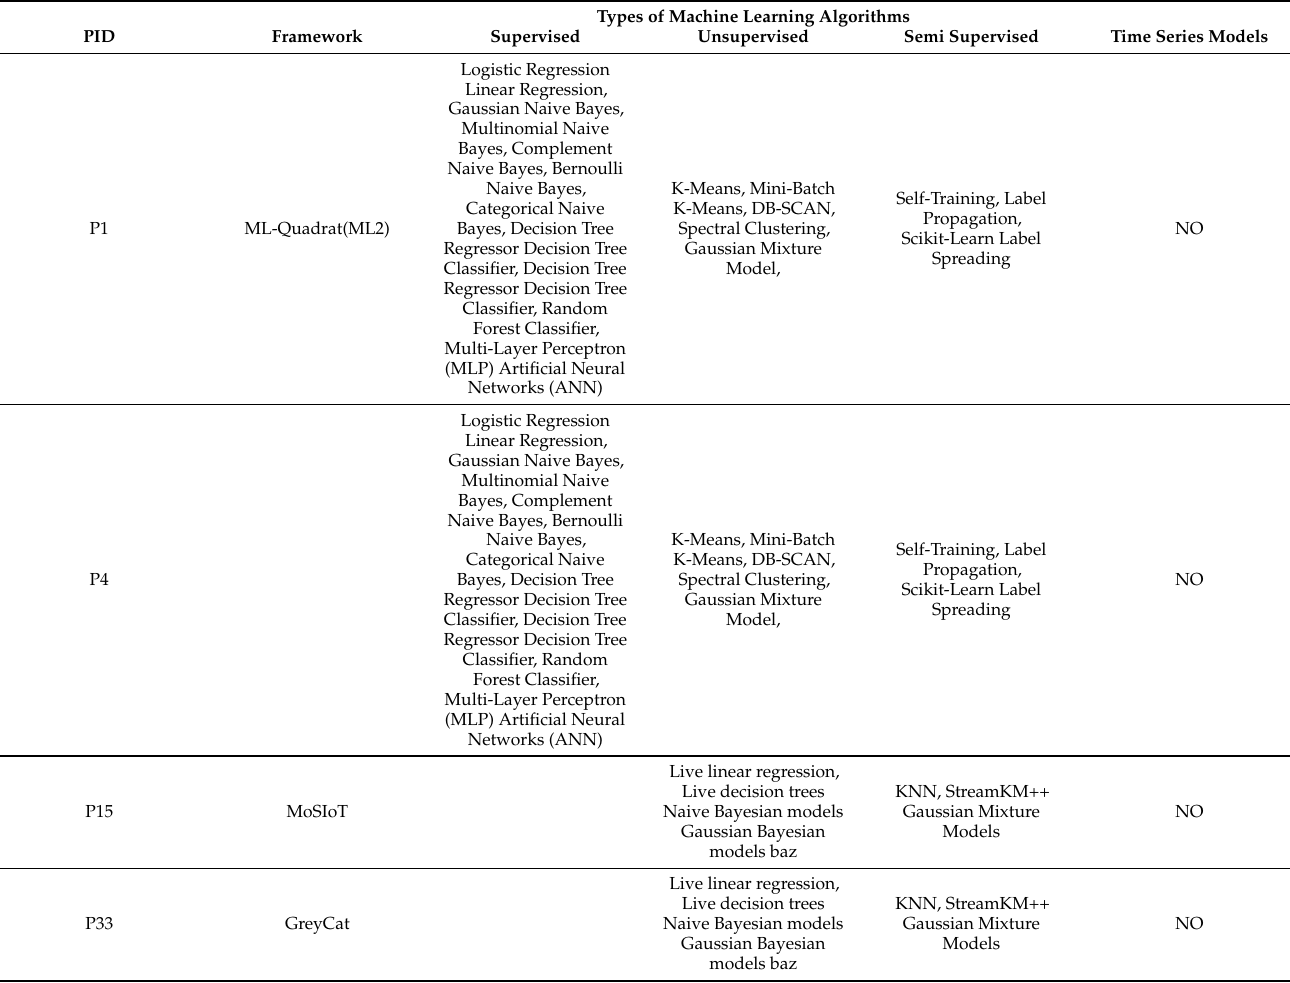
Table 6. Data Analytics and Machine Learning in MDE4IoT.